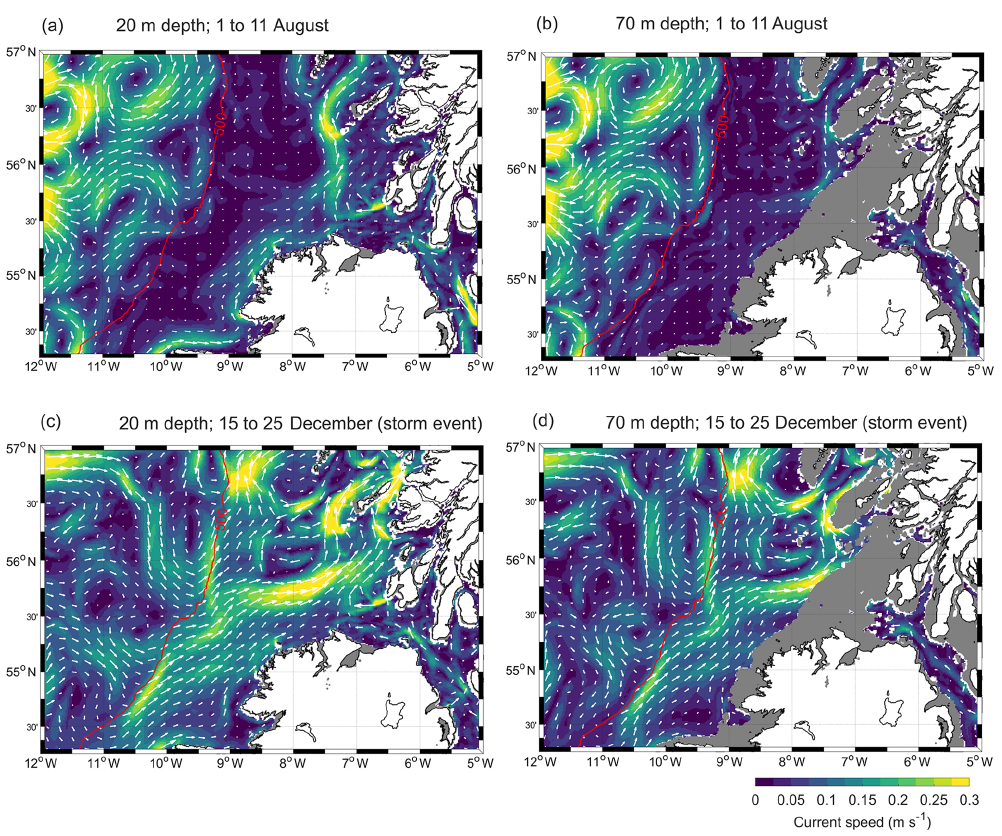
Figure 8. Average horizontal current velocity in the AMM15 model for (a) 1–11 August 2013 at 20m of depth, (b) 1–11 August 2013 at 70m of depth, (c) 15–25 December 2013 at 20m of depth, and (d) 15–25 December 2013 at 70m of depth. Bathymetry contour (red) from EMODnet bathymetry (https://www.emodnet-bathymetry.eu/, last access: September